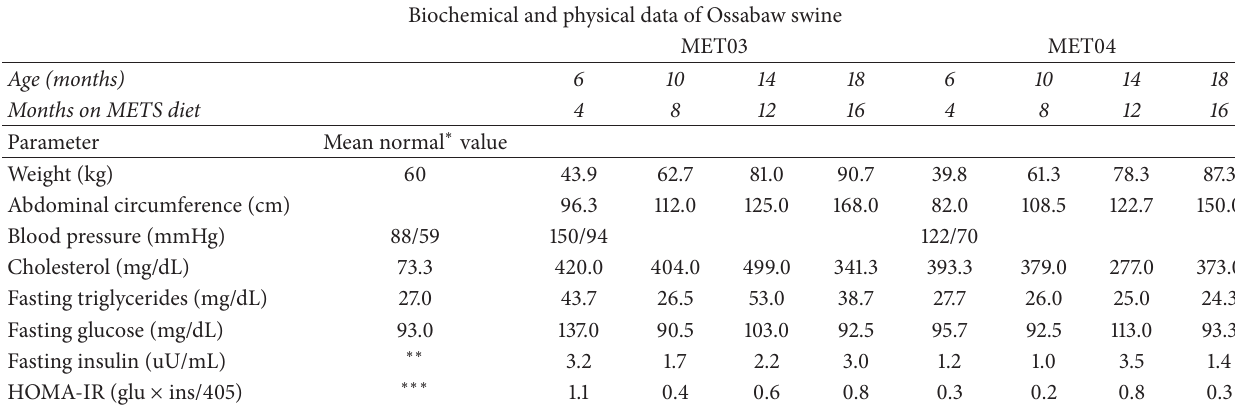
Table 1: Biologic, hematologic, and serum biochemical data collected from Ossabaw swine to determine metabolic status. Animals exhibited at least three of the four cardinal features of MetS (central obesity, dyslipidemia, and hypertension) after 4 months on the high fat diet. Insulin resistance cannot be determined from this data due to the fact that values are averaged over each quarter and overlap periods in which pigs were treated with the SCD. Serial glucose tolerance testing (data not shown) indicated a trend toward insulin resistance in both animals. Biochemical and physical data of Ossabaw swine